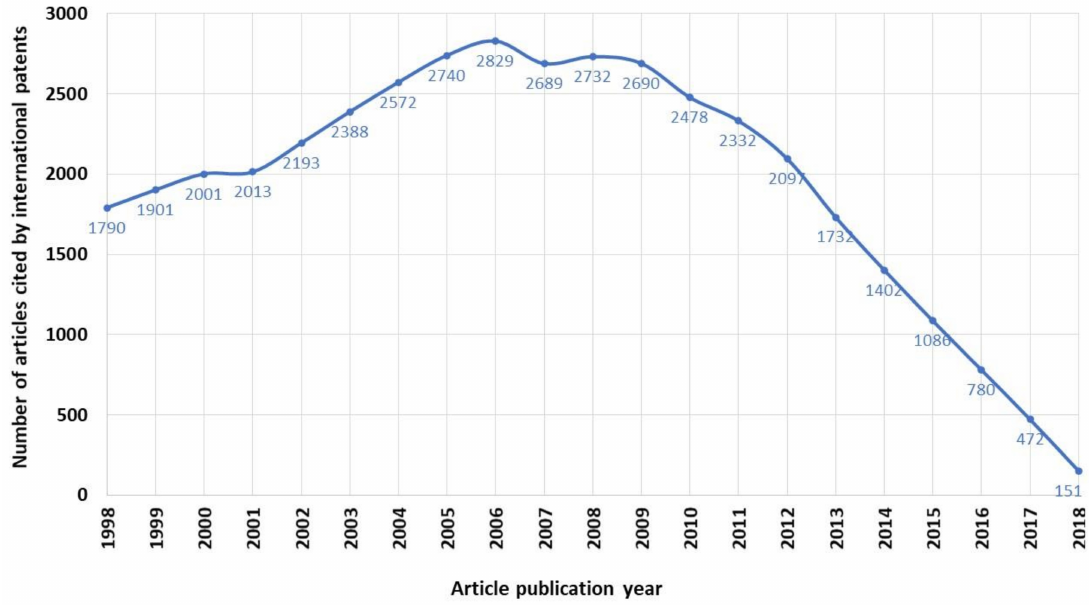
Figure 2. Publications cited by international patents and R&D funding in Spain.